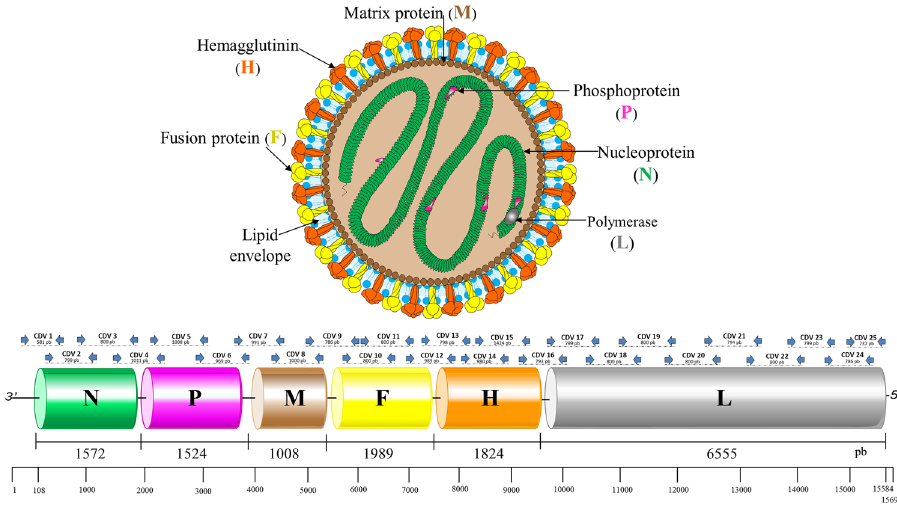
Figure 1. Schematic organization of the canine distemper virus (CDV) genome and primer